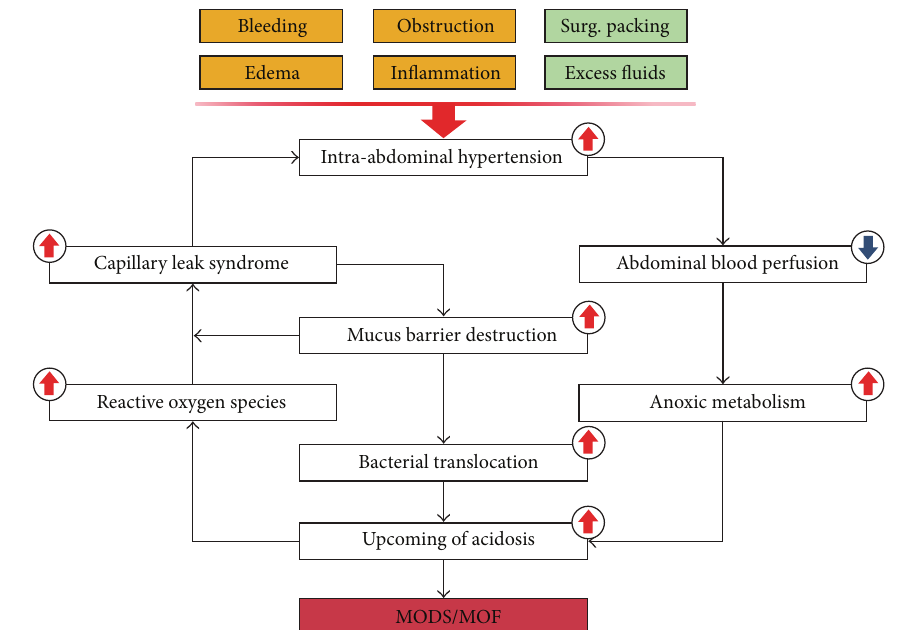
Figure 1: The vicious cycle of persistent intra-abdominal hypertension in patients with IAI. In clinical practice, iatrogenic measures such as surgical packing and fluid treatment would result in the development of intra-abdominal hypertension. All clinical conditions listed here should be paid close attention. This cycle provides sufficient information for the poor outcomes of IAH once the persistent hypertension is not well